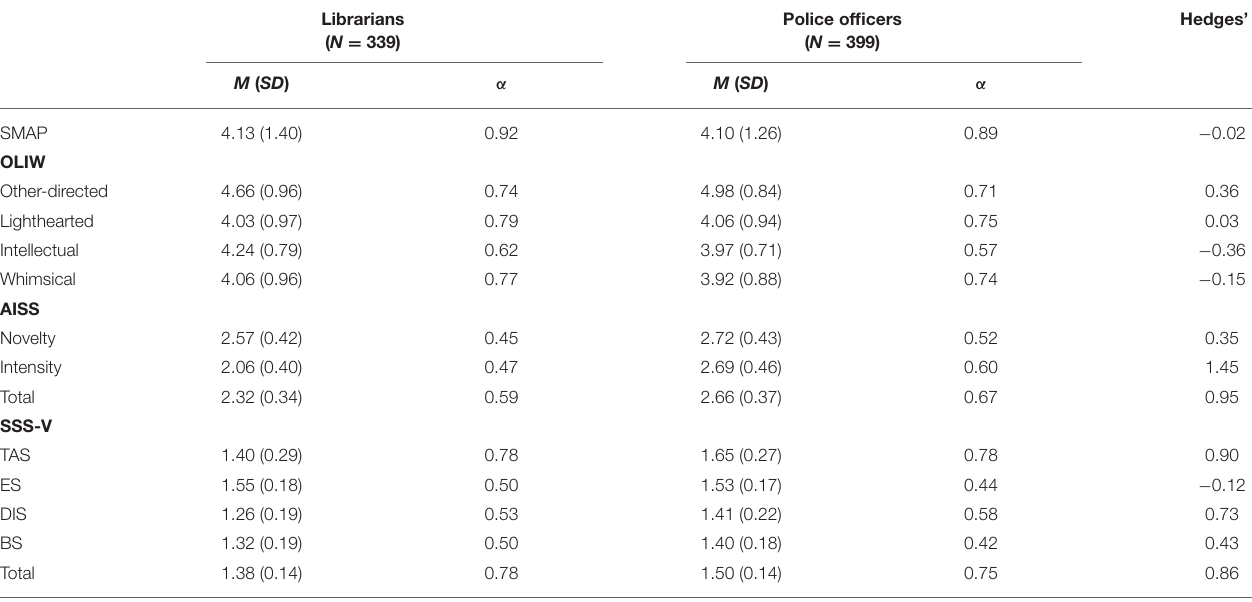
TABLE 1 | Descriptive statistics and internal consistencies for the playfulness and sensation seeking scales. Librarians ( N =